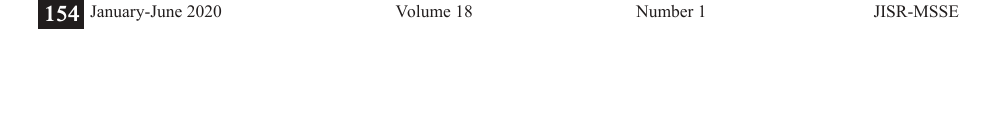
Figure 1: Graphic presentation of the concept of social identity psychology by Tajfel et